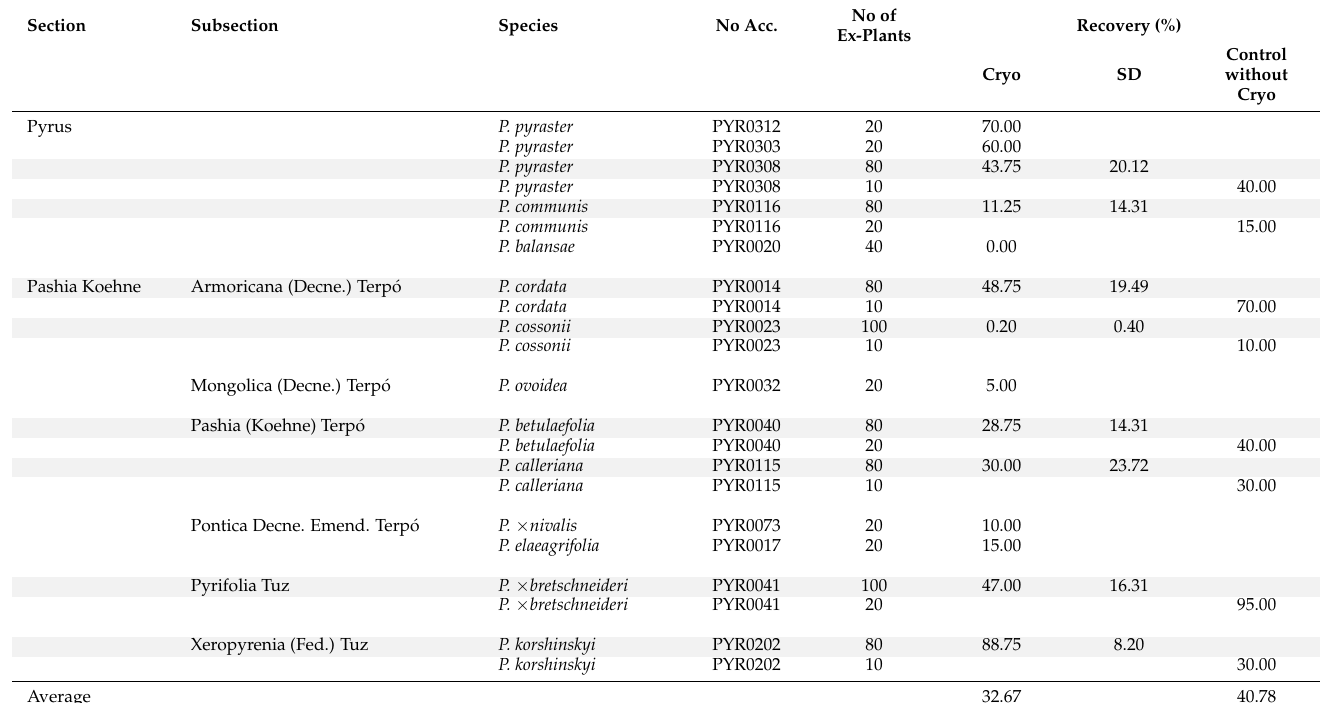
Table 3. Mean recovery rates after cryopreservation (%) by using PVS2 vitrification of shoot tips is dependent on the Pyru s species. In the first two years, controls without cryopreservation were additionally analyzed for some accessions.